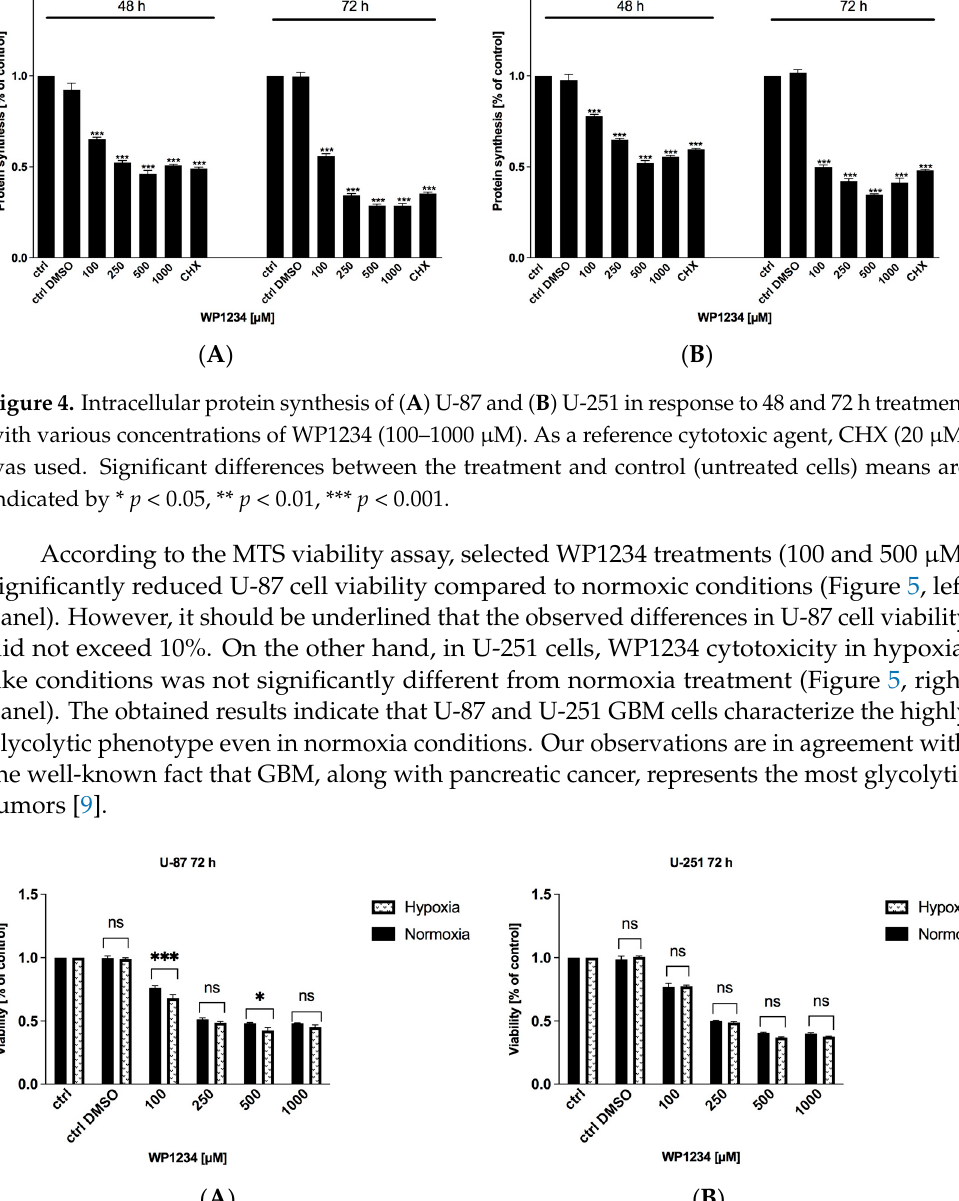
Figure 5. ( A ) U-87 and ( B ) U-251 cells viability after 72 h treatment with various concentrations of WP1234 (100–1000 μ M) in normoxia and hypoxia-like (DMOG + Rho) conditions. Significant differ- ences between the treatment means and control (untreated cells) value are indicated by * p < 0.05, ** p < 0.01, *** p < 0.001; (ns—no significance).